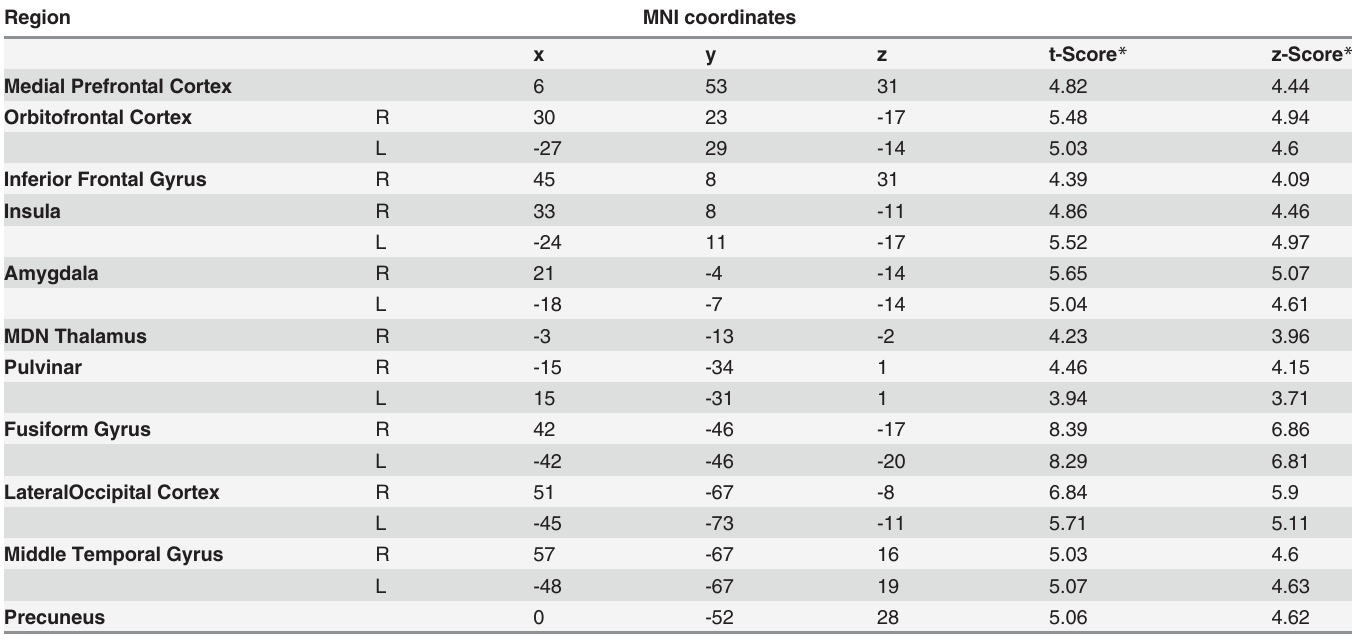
Table 1. Activation network for the main effect of emotion ( ‘ negative > neutral ’ IAPS pictures; all subjects included).